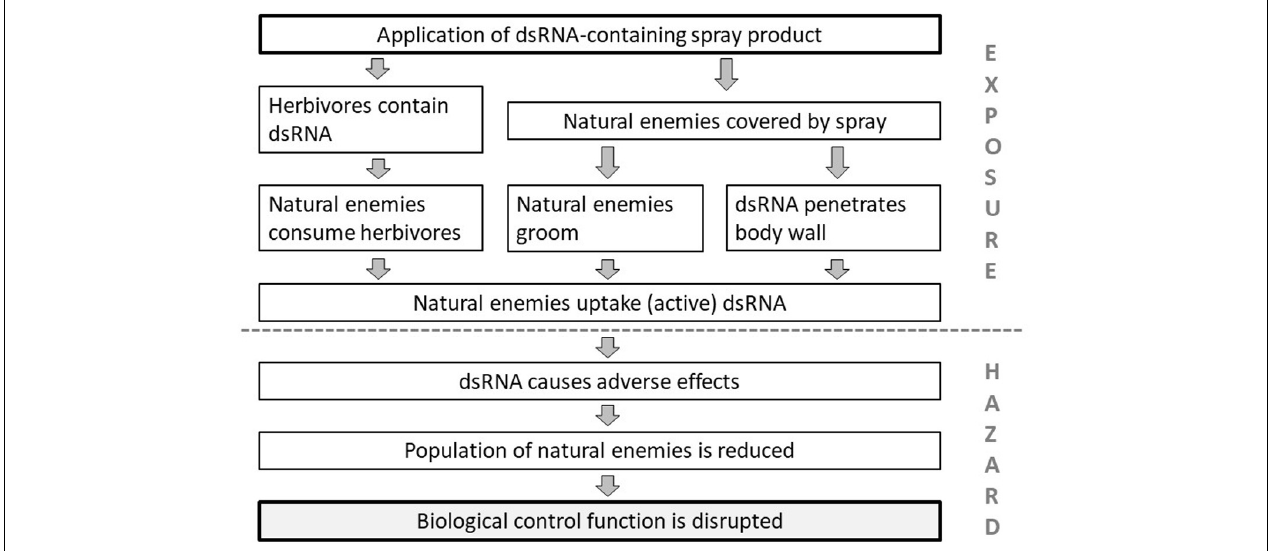
FIGURE 1 | Plausible pathways to harm. Steps on how the application of a dsRNA-based spray insecticide could cause harm to the protection goal of “biological pest control” by affecting arthropod natural enemies (predators and